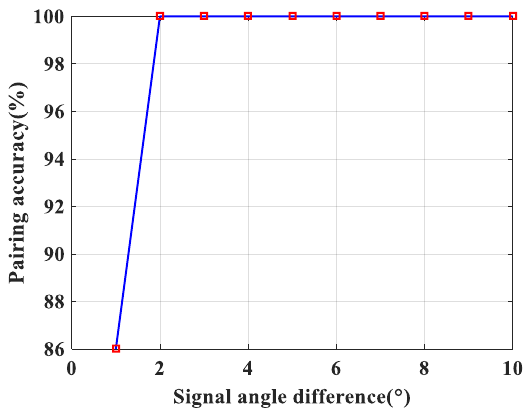
) = ( 2 MHz,1 λ ,10 ◦ ,20 ◦ ,20 ◦ ,60 ◦ ) . ( f 5 , r 5 , ϕ 5 , θ 5 , γ 5 , η 5